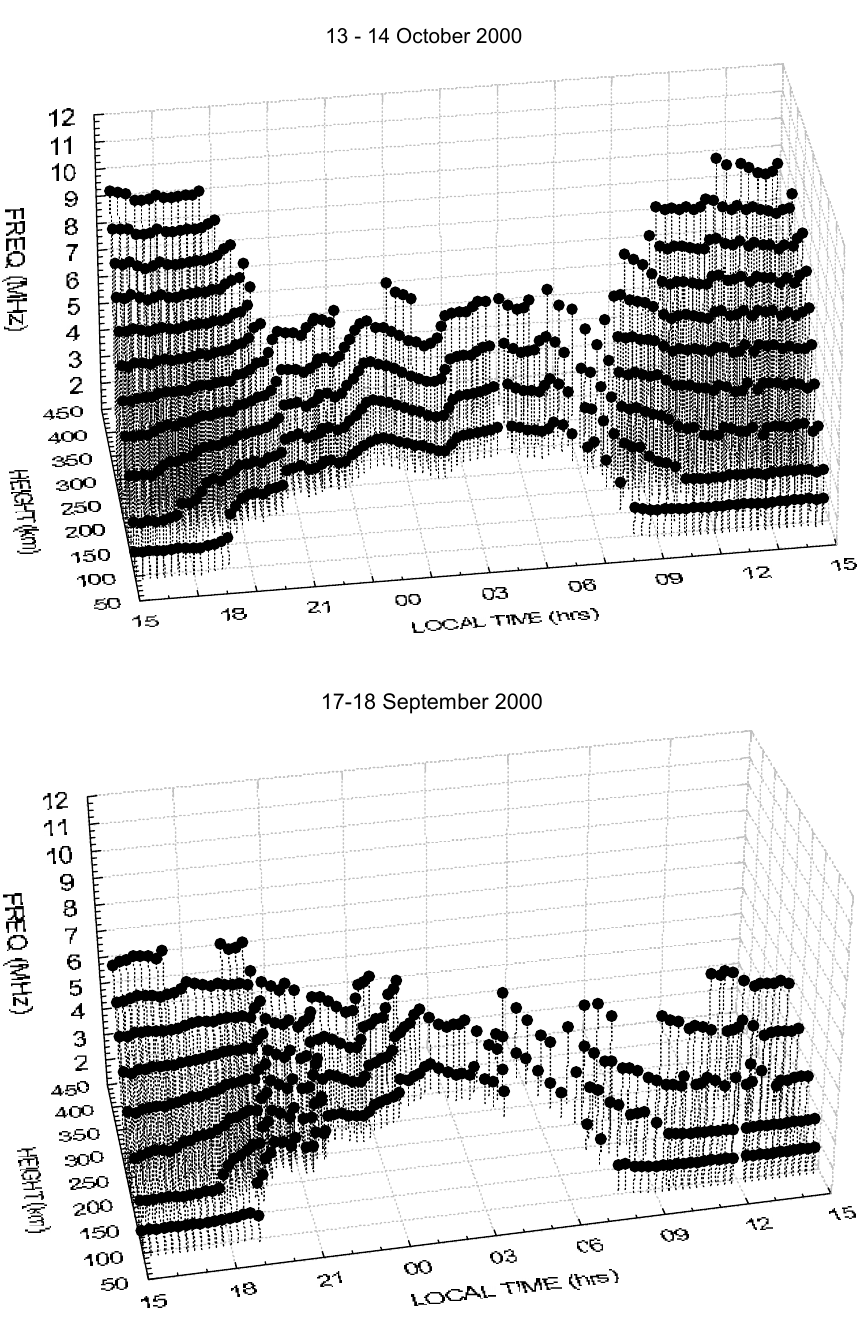
Fig. 7. The 3-D plot of the height vari- ation for plasma frequencies 2–12MHz versus the local time for the night hours between 17 and 18 September 2000. Ionisation depletion was observed over